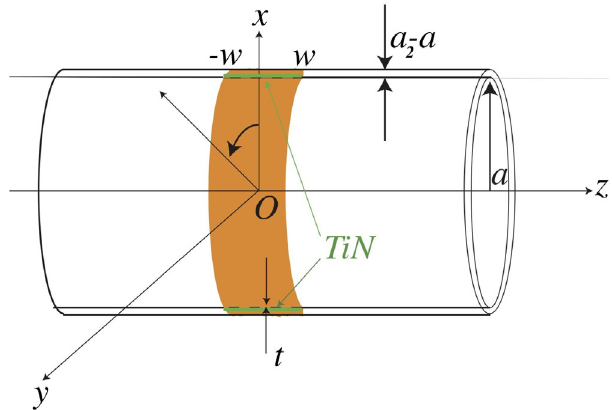
FIG. 1. Schematic of the ceramic break (orange object), sandwiched by perfectly conductive metal chambers. The inner and outer radii and length of the ceramic are denoted by a þ t , a 2 and g ð¼ 2 w Þ , respectively. The inner surface of the ceramic is coated by a TiN (green) with thickness t ½ ≪ ð a 2 − a Þ(cid:2)